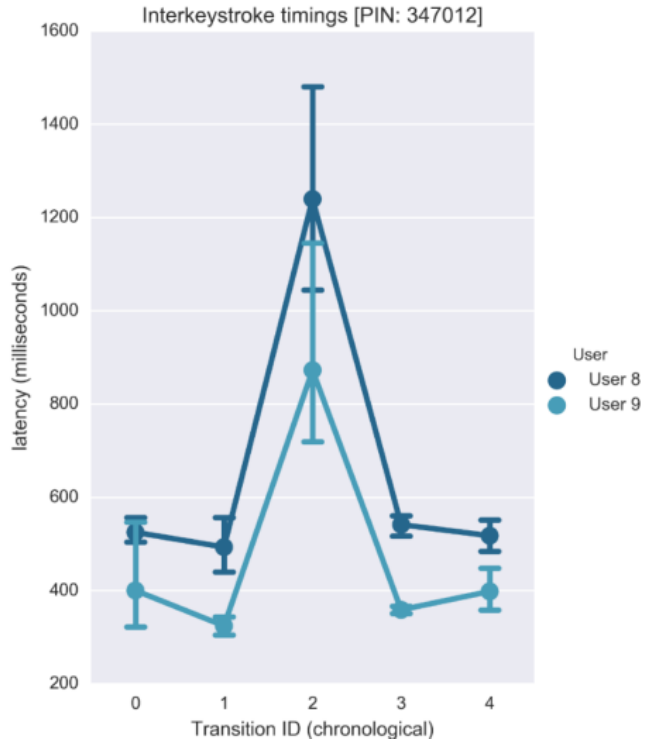
Figure 11. Inter-keystroke variation on 2 users.